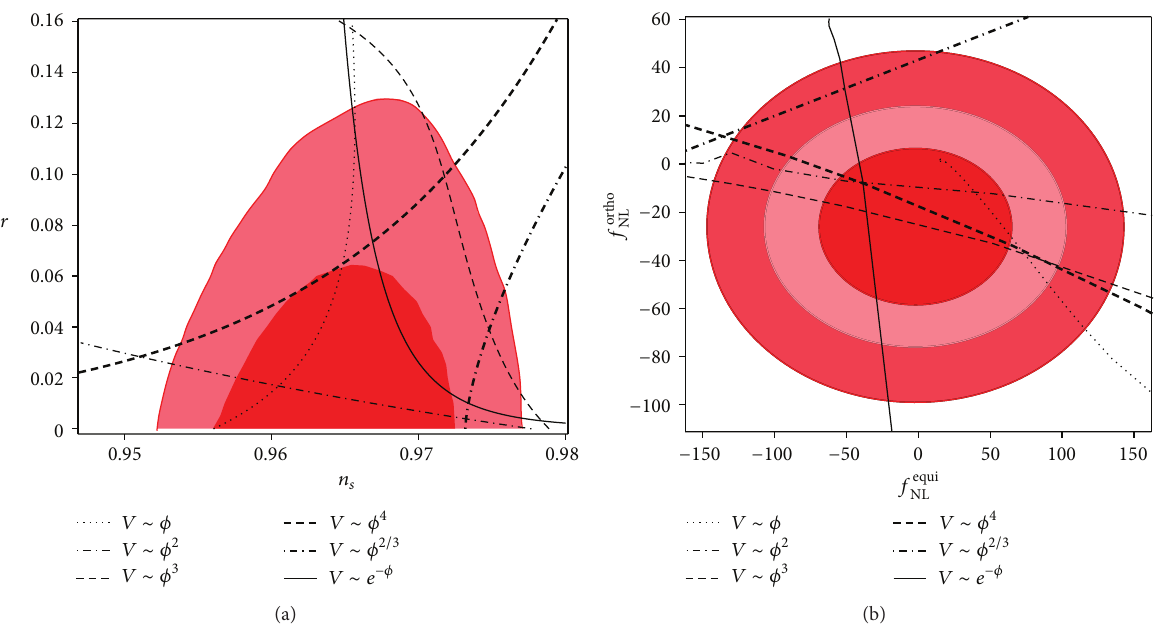
Figure 1: Tensor-to-scalar ratio versus the scalar spectral index for an inflationary model in which both the inflaton and its derivative are nonminimally coupled to gravity, in the background of the Planck 2015 TT, TE, and EE + lowP data (a) and the amplitude of the orthogonal configuration of the non-Gaussianity versus the amplitude of the equilateral configuration for an inflationary model in which both inflaton and its derivative are nonminimally coupled to gravity, in the background of Planck 2015 TTT, EEE, TTE, and EET data (b). Figure is plotted with 𝑛 = 1 , 𝑓(𝜙) ∼ 𝜉𝜙 2 , and various types of the potential, for 𝑁 = 60 . Note that the parameter 𝜉 varies along the curves.